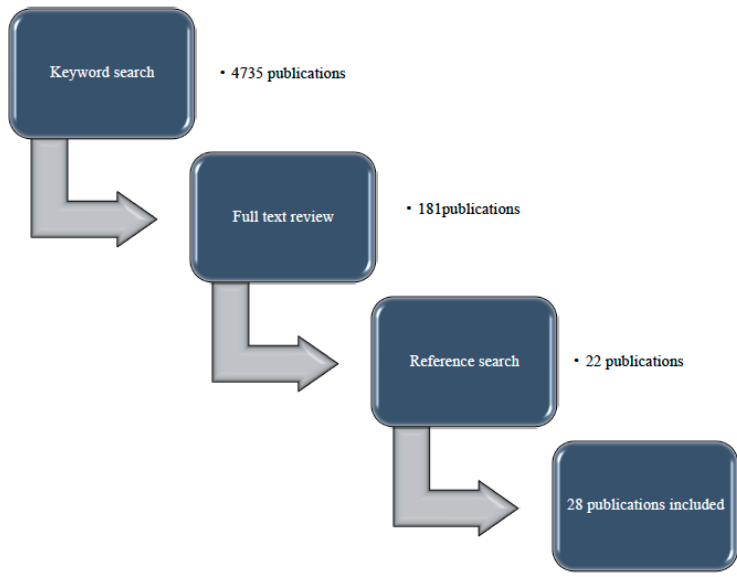
Figure 1. Flowchart of the selection process for the publications included.